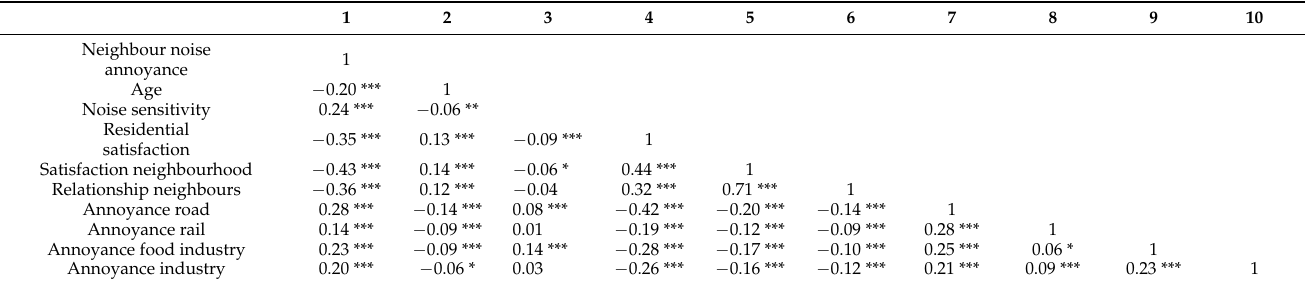
Table 3. Product–moment correlations between potential contributors to neighbour noise